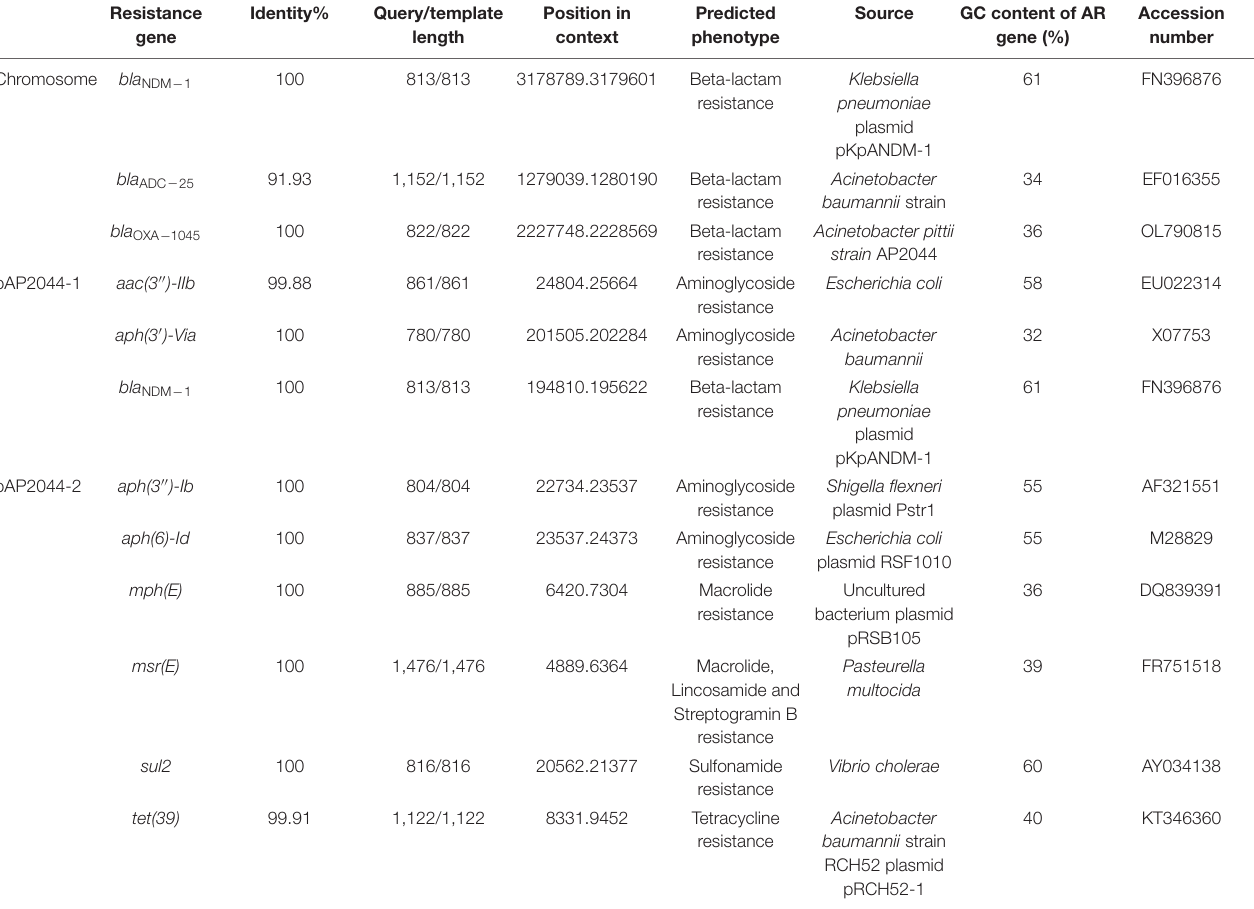
TABLE 3 | Resistance gene distribution in Acinetobacter pittii strain AP2044. Resistance Identity% Query/template Position in gene length